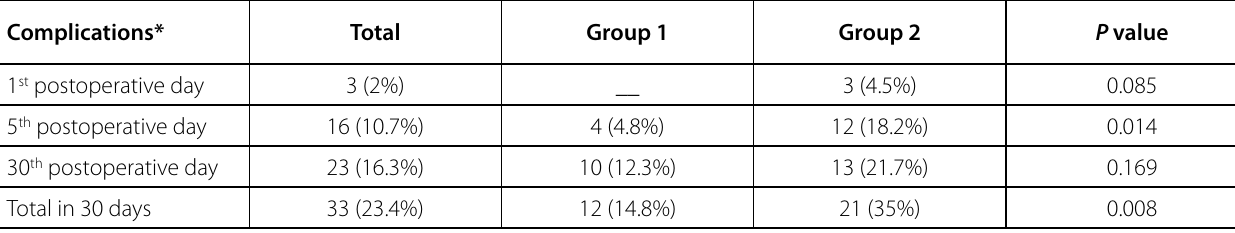
Table 3. Complications in the operative wound of the